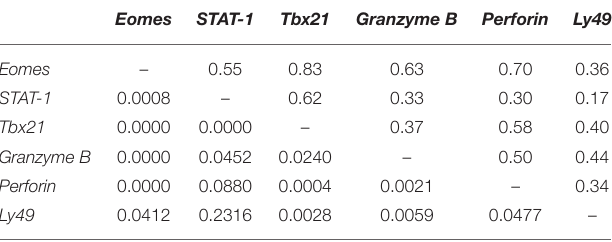
TABLE 2 | Spearman’s correlation coefficients of genes expressed by NK and CD 8 + T